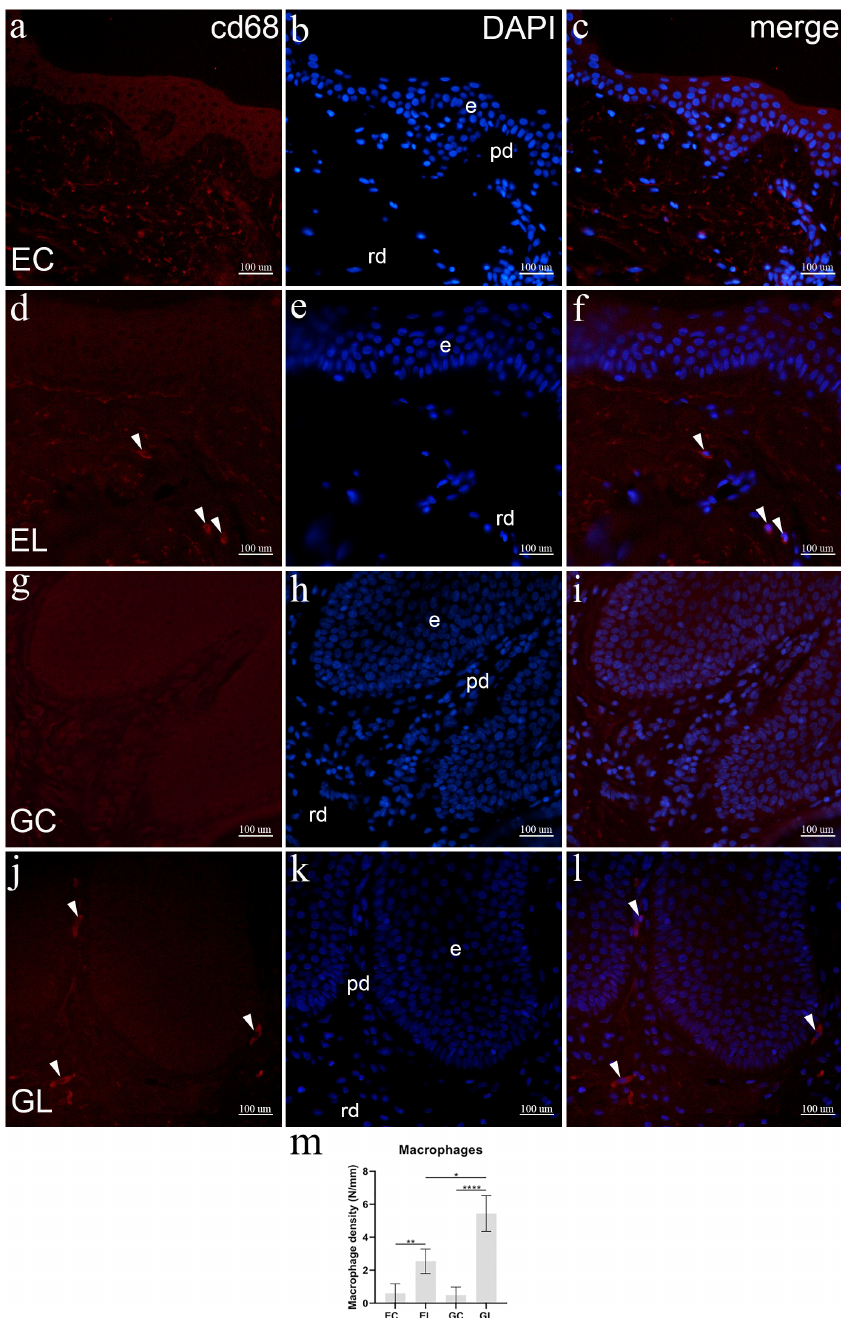
Figure 7. Expression of CD68 in normal skin and lichen sclerosus skin samples. The epidermis (e), papillary dermis (pd), and reticular dermis (rd) are marked on DAPI staining images which display all cell nuclei ( b , e , h , k ). EC—normal extragenital skin ( a – c ): no CD68 positive cells are displayed. EL—extragenital skin affected by lichen sclerosus ( d – f ): several macrophages are demonstrated by CD68 expression (arrowheads, ( d , f )). GC—normal vulvar skin ( g – i ): CD68 expression is not observed in dermal cells. GL—vulvar skin affected by lichen sclerosus ( j – l ): CD68-positive macrophages are seen in the dermis (arrowheads, ( j , l )). Immunofluorescence staining to CD68 and DAPI, × 400 mag- nification. Analysis of macrophage cell density ( m ); statistical significance was determined by the Kruskal–Wallis test. N/mm denotes the number of macrophages per mm of dermal-epidermal junction. Graphs display mean values with standard deviations shown by error bars. The significance of differences is marked by asterisks: * p < 0.05, ** p < 0.01, **** p <